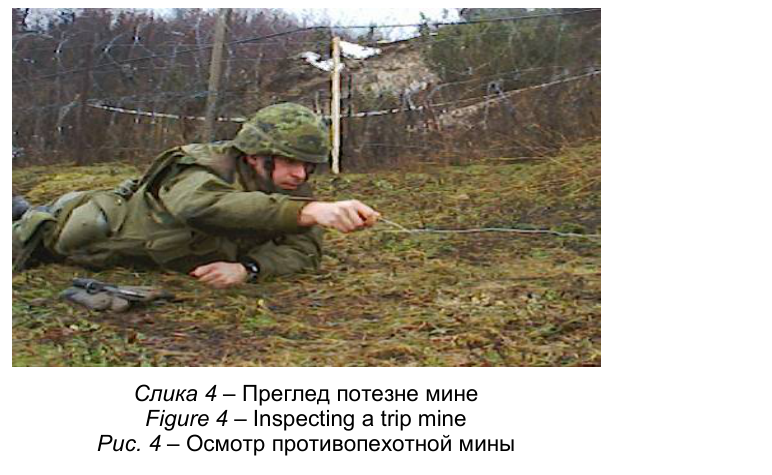
Figure 4 – Inspecting a trip mine Рис . 4 – Осмотр противопехотной